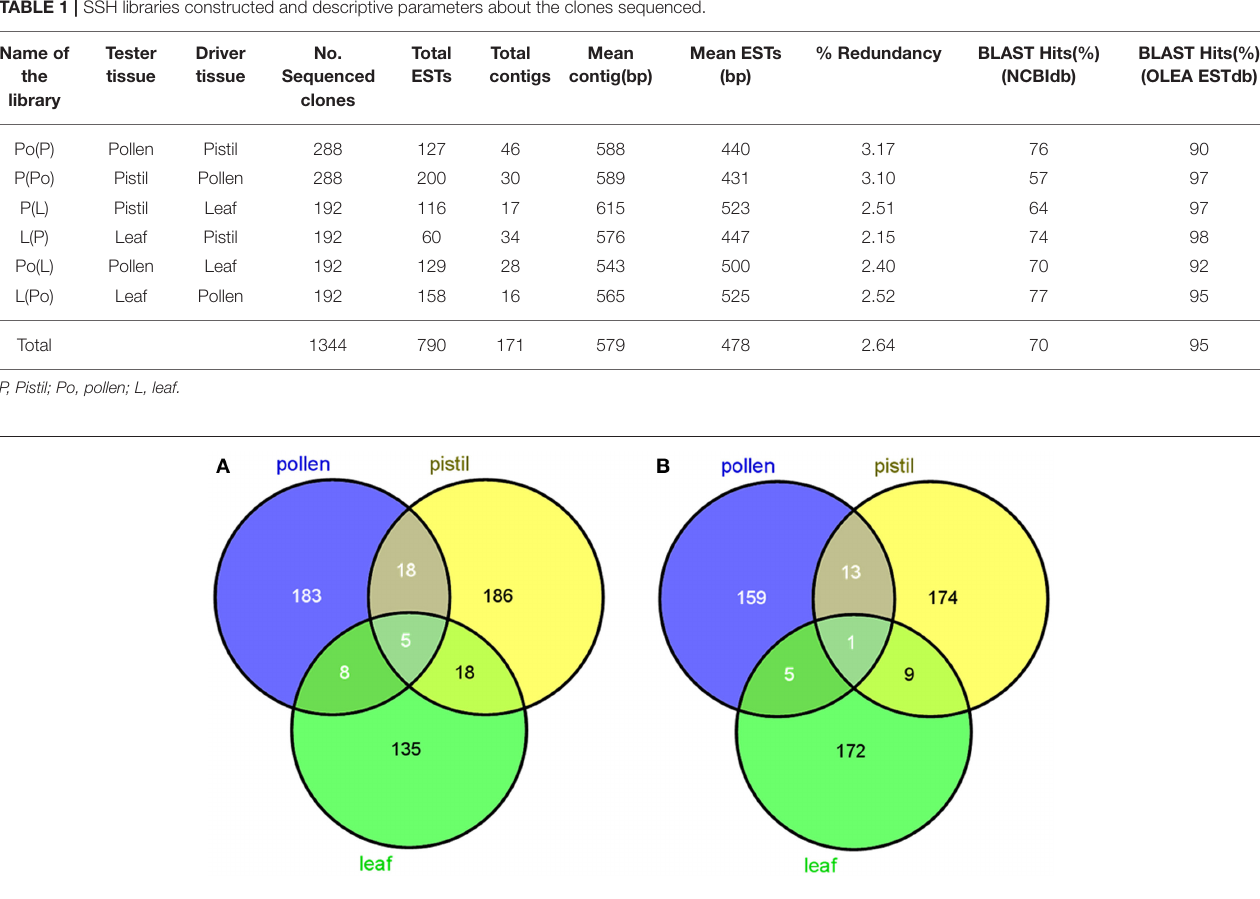
FIGURE 1 | Venn diagrams showing the number of specific and common transcripts to the three tissues tested. (A) Output data after using OLEA ESTdb, and NCBIdb (B) , respectively